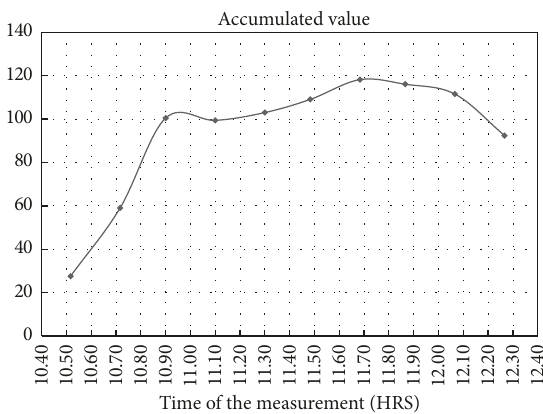
Figure 6: Magnitude of the correlation matrix as a function of real